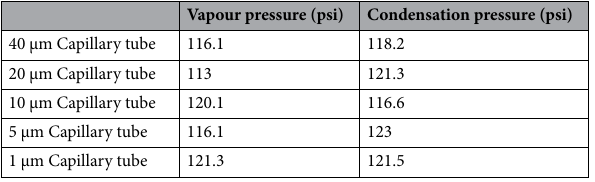
Table 1. Vapour and condensation pressures of propane in several capillary-tube sizes.